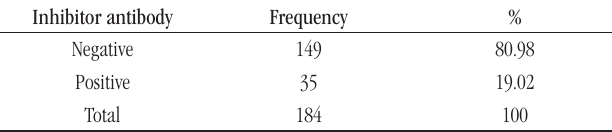
taBLE 2 − Incidence of anti-factor VIII inhibitor antibody in studied patients Inhibitor antibody